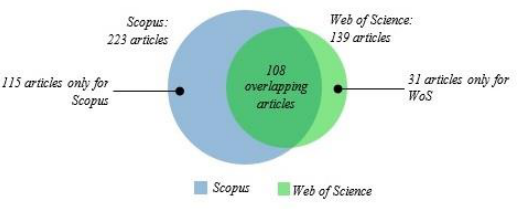
Figure 2. Articles about BoP in the Scopus and Web of Science Databases